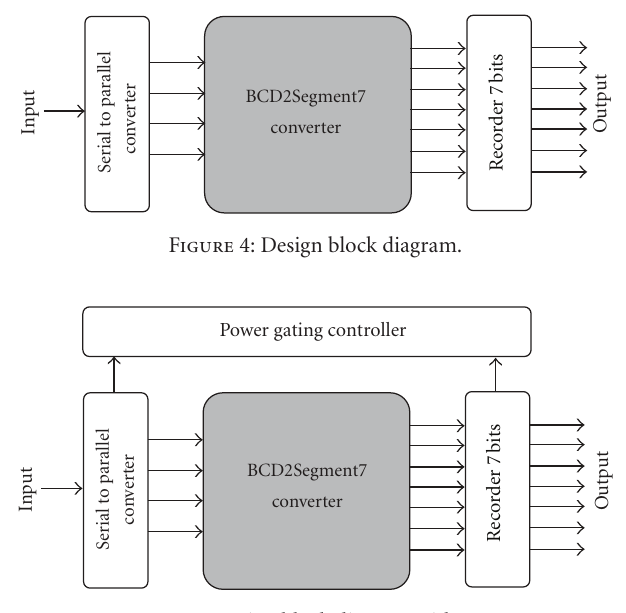
Figure 5: Design block diagram with